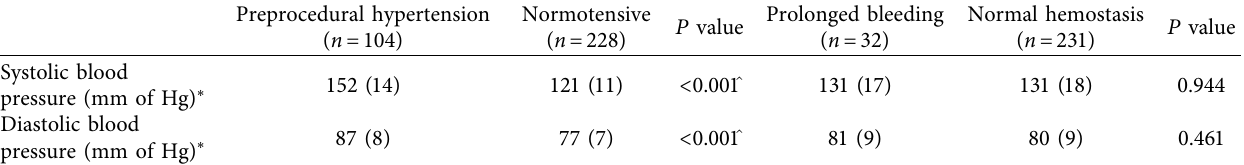
Table 2: The distribution of the systolic and diastolic blood pressures stratified by preprocedural hypertension. Preprocedural hypertension